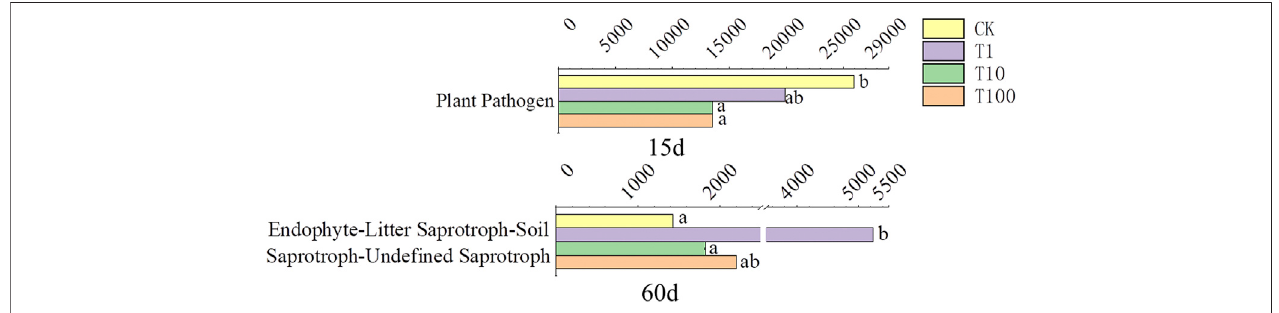
FIGURE 5 | Fungal functions predicted by FUNGuild. Letters “ a ” and “ b ” on the right of the columns mean signi fi cance of difference ( p <